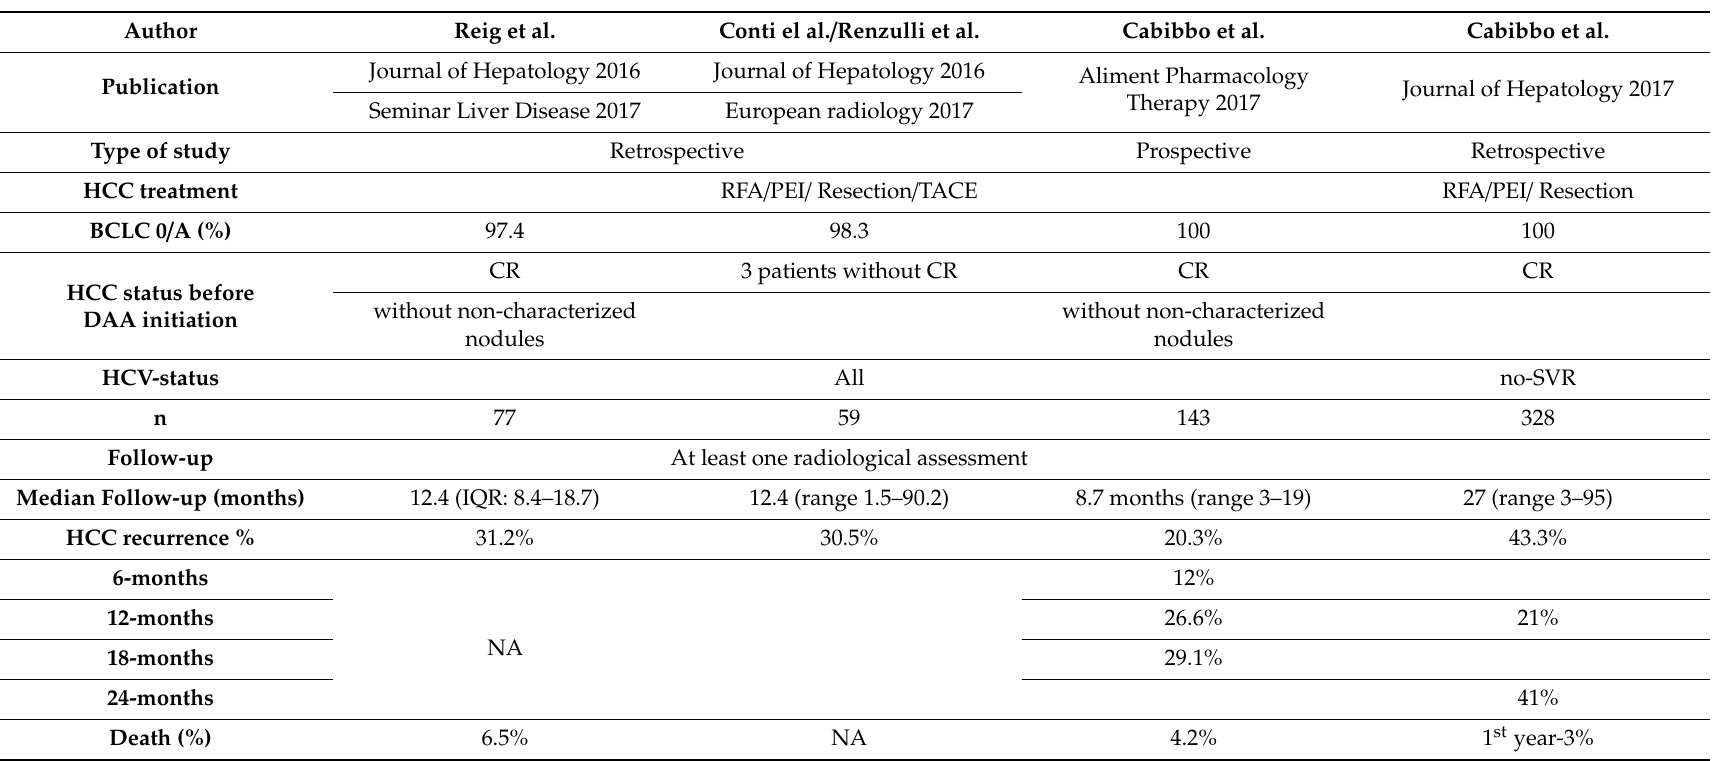
Table 2. Characteristics of the studies reporting HCC recurrence after DAA treatment or